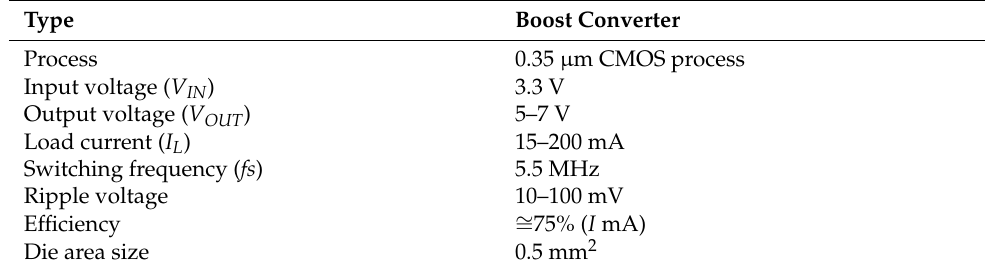
Table 1. Performance summary.